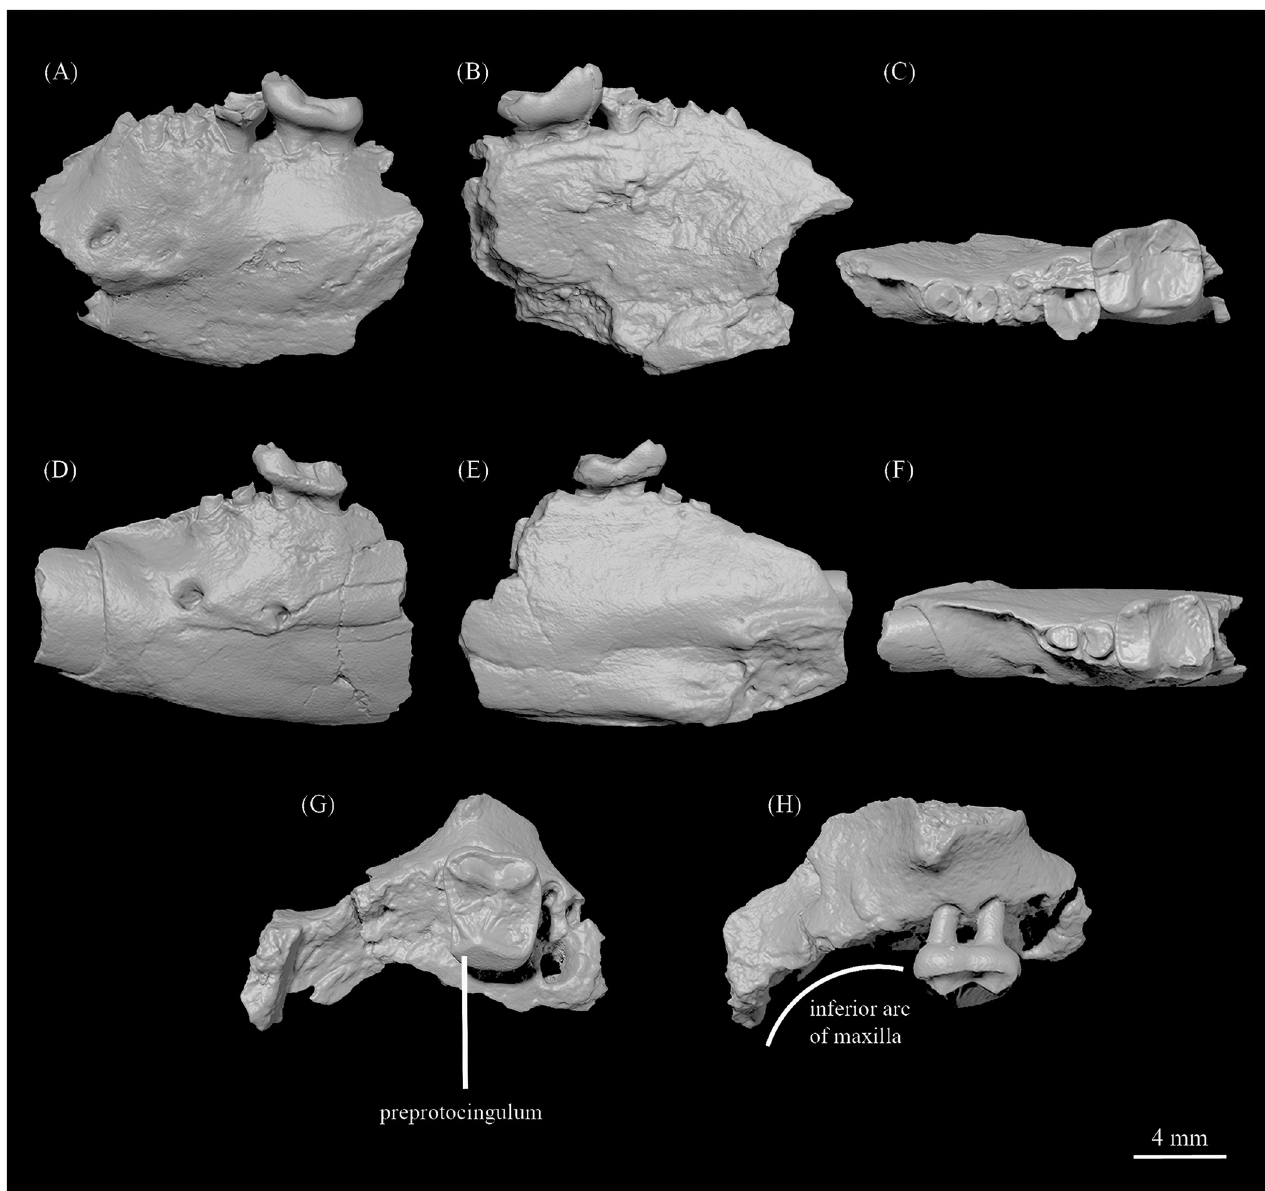
Fig 2. Dentition of Ignacius mckennai sp. nov. from Ellesmere Island, Nunavut, Canada. A-C, CMN 30850, left dentary fragment with M 2 in buccal ( A ), lingual ( B ), and occlusal ( C ) views; D-F, CMN 30986, left dentary fragment with M 1 in buccal ( D ), lingual ( E ), and occlusal ( F ) views; G, H , CMN 30830 (holotype), left maxillary fragment with M 1 in occlusal ( G) and buccal ( H ) views.